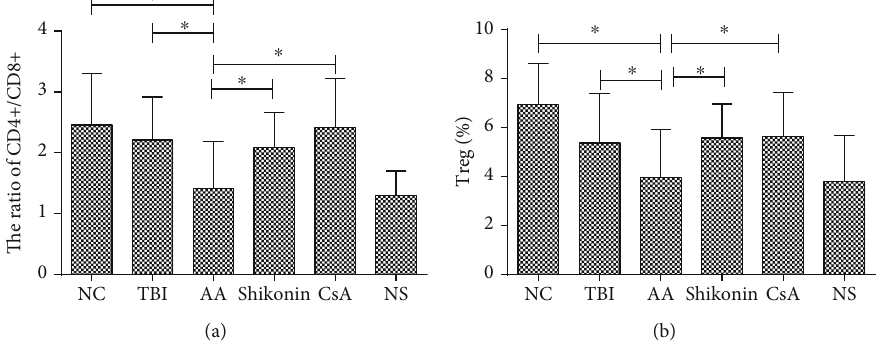
Figure 5: (a) TheratioofCD4+/CD8+in theAA groupwassigni fi cantlylowerthan thosein theTBI, NC,shikonin,and CsAgroups( p < 0 : 05 ). (b) The frequency of Treg in the AA group was signi fi cantly lower than those in the TBI, NC, shikonin, and CsA groups ( p < 0 : 05 ). AA: aplastic anemia ( n = 17 ); TBI: total body irradiation ( n = 10 ); NC: normal control ( n = 10 ); shikonin ( n = 10 ); CsA: cyclosporin A ( n = 10 ); NS: normal saline ( n = 10 ) ( ∗ p < 0 : 05 ).